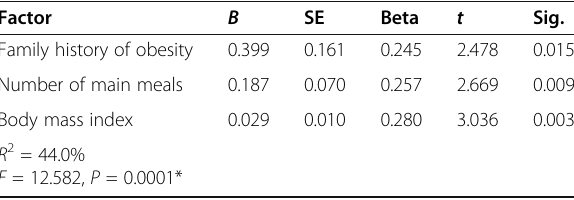
Table 4 Multiple regression analysis of variables associated with HOMA-IR before the intervention Factor B SE Beta t